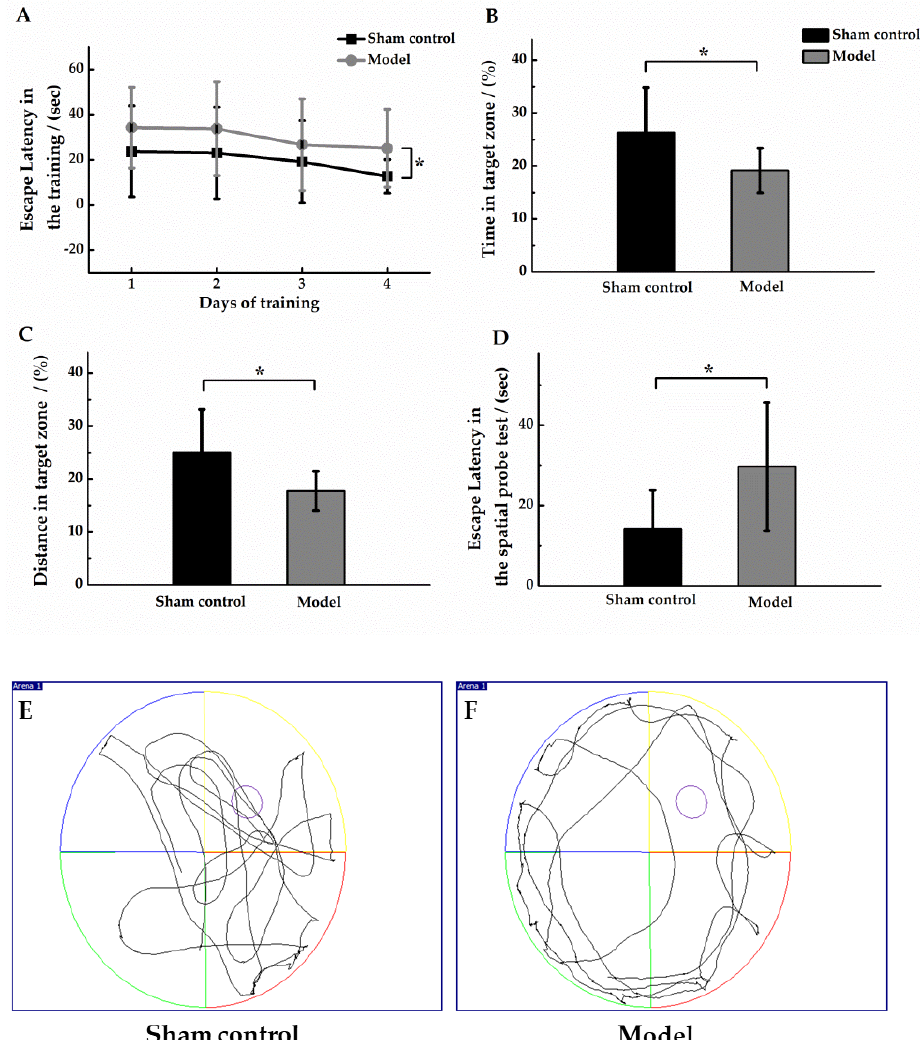
Figure 3. Morris Water Maze test in sham control group ( n = 10) and model group ( n = 12). ( A ) Mean escape latency for both groups of animals. Training was performed three times per day for four days. In the spatial probe test, the ratio (%) of the residence time in the target area to the total time ( B ); the ratio (%) of the distance swam by the animal in the target area to the total distance swam ( C ); and the escape latency was defined as the time when the animal first crossed the location of the hidden platform ( D ). Compared with the sham control group, * p < 0.05. In the spatial probe test, the movement trajectories (60 s duration) of one mouse in the sham control group ( E ) and model group ( F ) were shown, and the platform was unavailable for